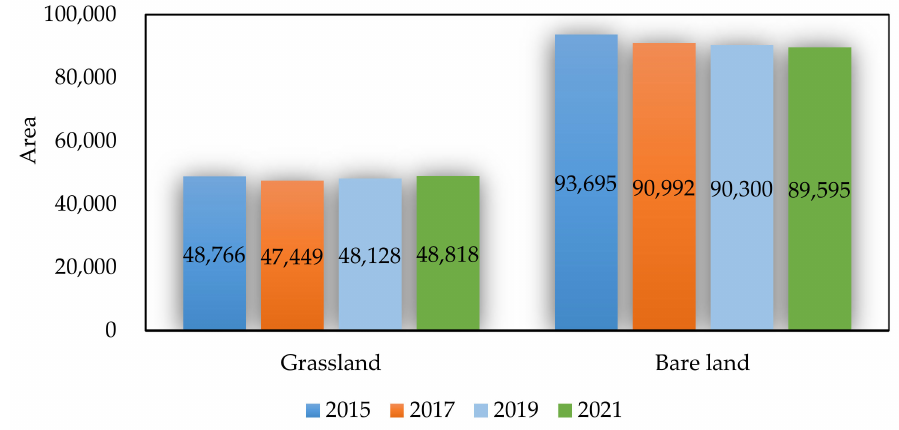
Figure 16. The changes to grassland and bare land